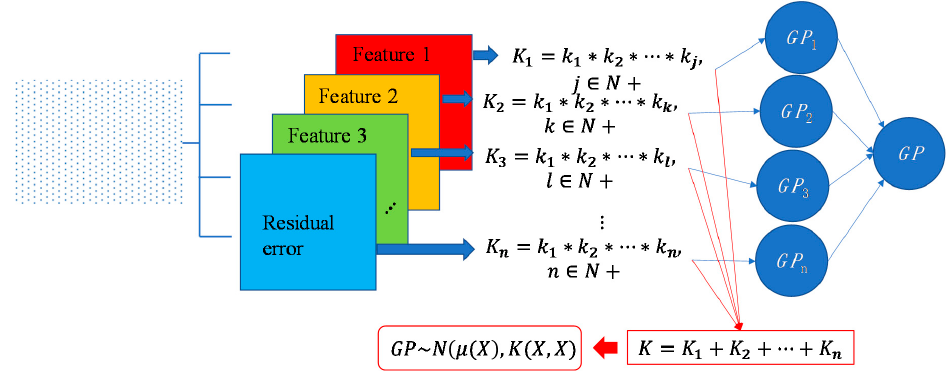
Figure 3. Design of composite covariance kernel functions.